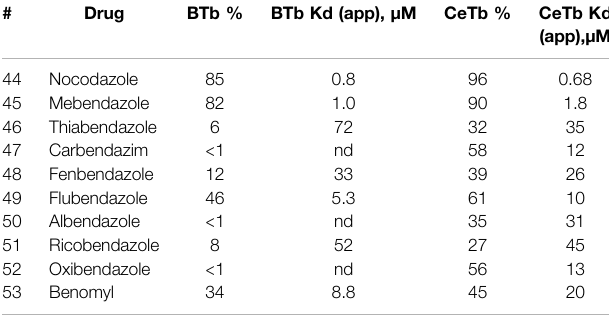
TABLE 8 | MDL competitive binding inhibition by benzimidazole